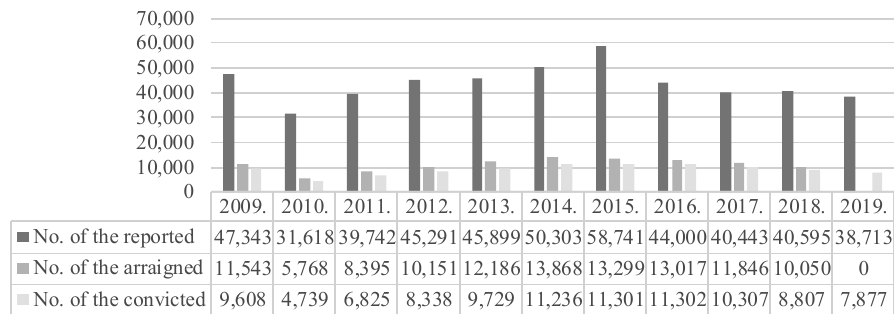
Chart 1: Number of reported, accused and convicted adults in the territory of the Republic of Serbia for criminal offenses against property in the period from 2009 to 2019